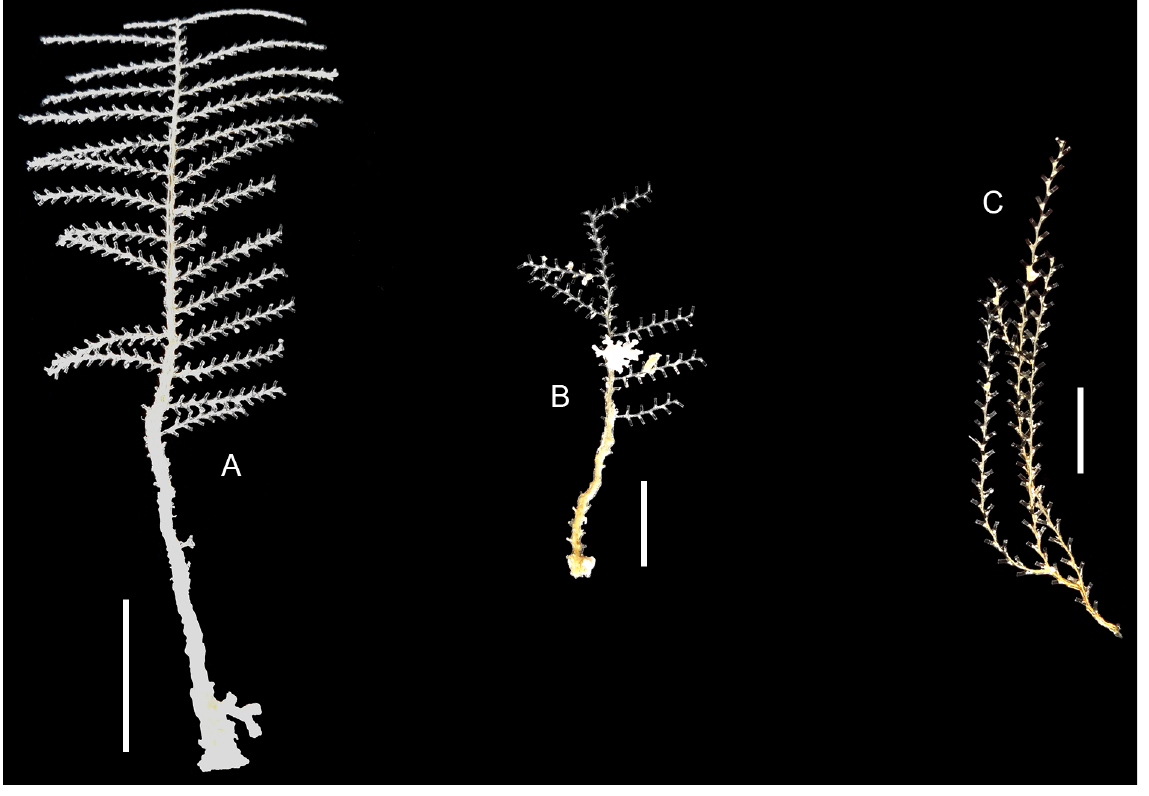
Fig. 3. A . Solenoscyphus candelabrum gen. et sp. nov., colony silhouette (holotype). B . Solenoscyphus decidualis gen. et sp. nov., colony silhouette (holotype). C . Solenoscyphus striatus gen. et sp. nov., colony silhouette (holotype). Scale bars: A = 2 cm; B–C = 1